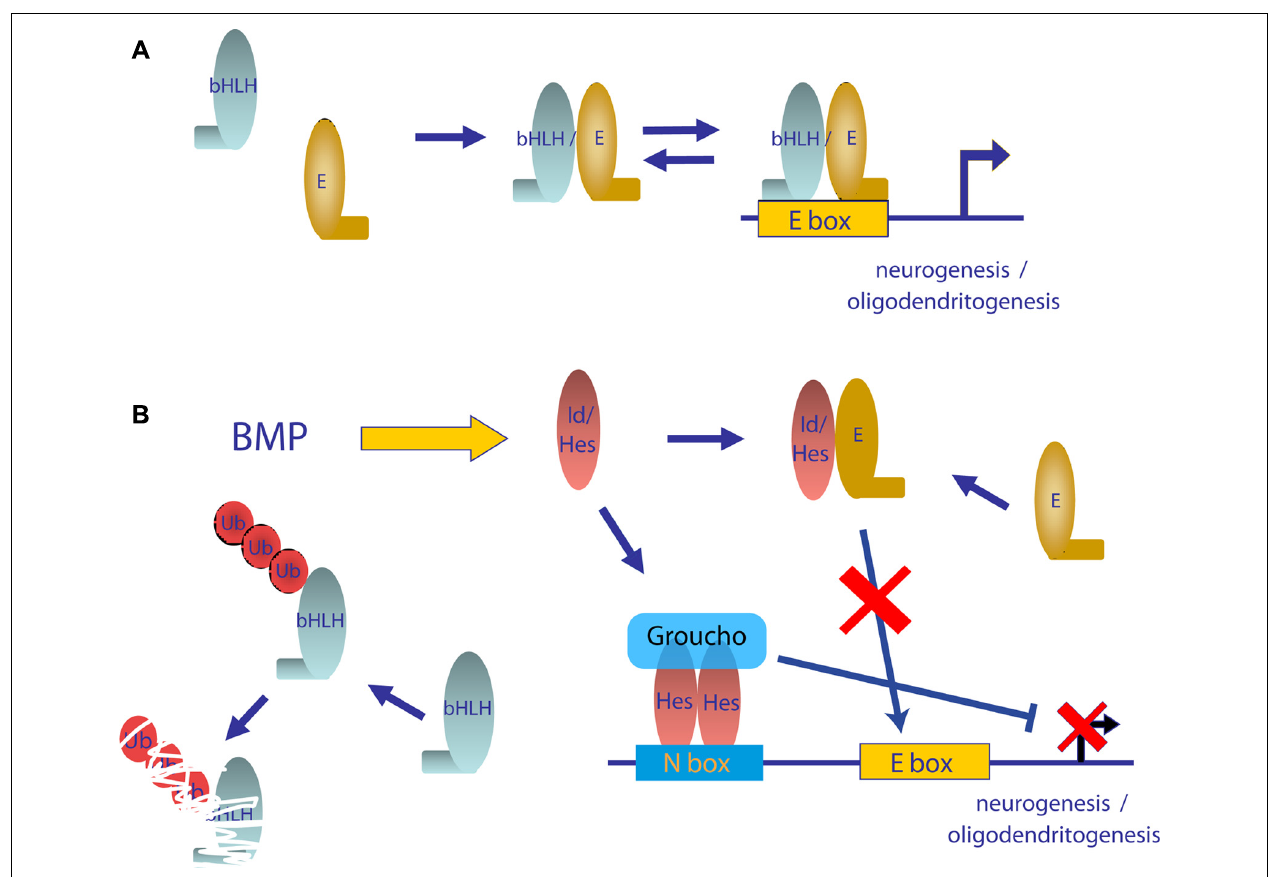
proteins sequester E proteins away from bHLH transcription factors, which leads to transcriptionally inactive complexes and also enhance degradation of bHLH monomers. Furthermore Hes proteins can bind to N boxes sequences in neural promoters and recruit the Groucho family of transcriptional